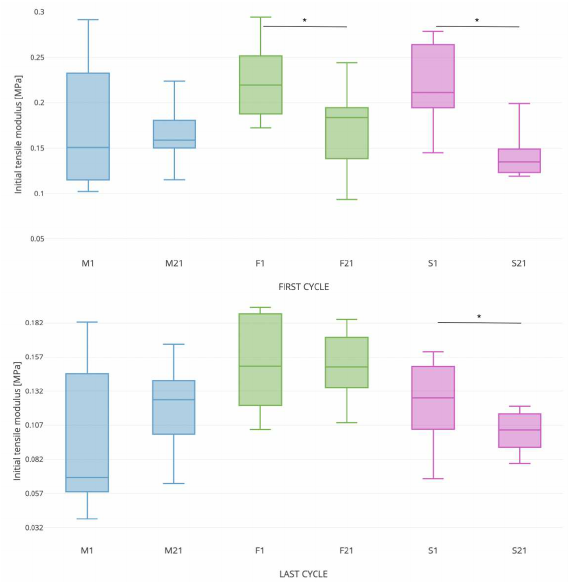
Figure 5. Box plot comparing the initial tensile modulus in the first and the last cycle 1. day (M1) and 21. (M21) day of samples exposed in medium, 1. (F1) and 21. day (F21) of fibroblast, 1. (S1) and 21 (S21) of osteoblast samples, * indicates statistically significant differences (Mann-Whitney, 0.05)